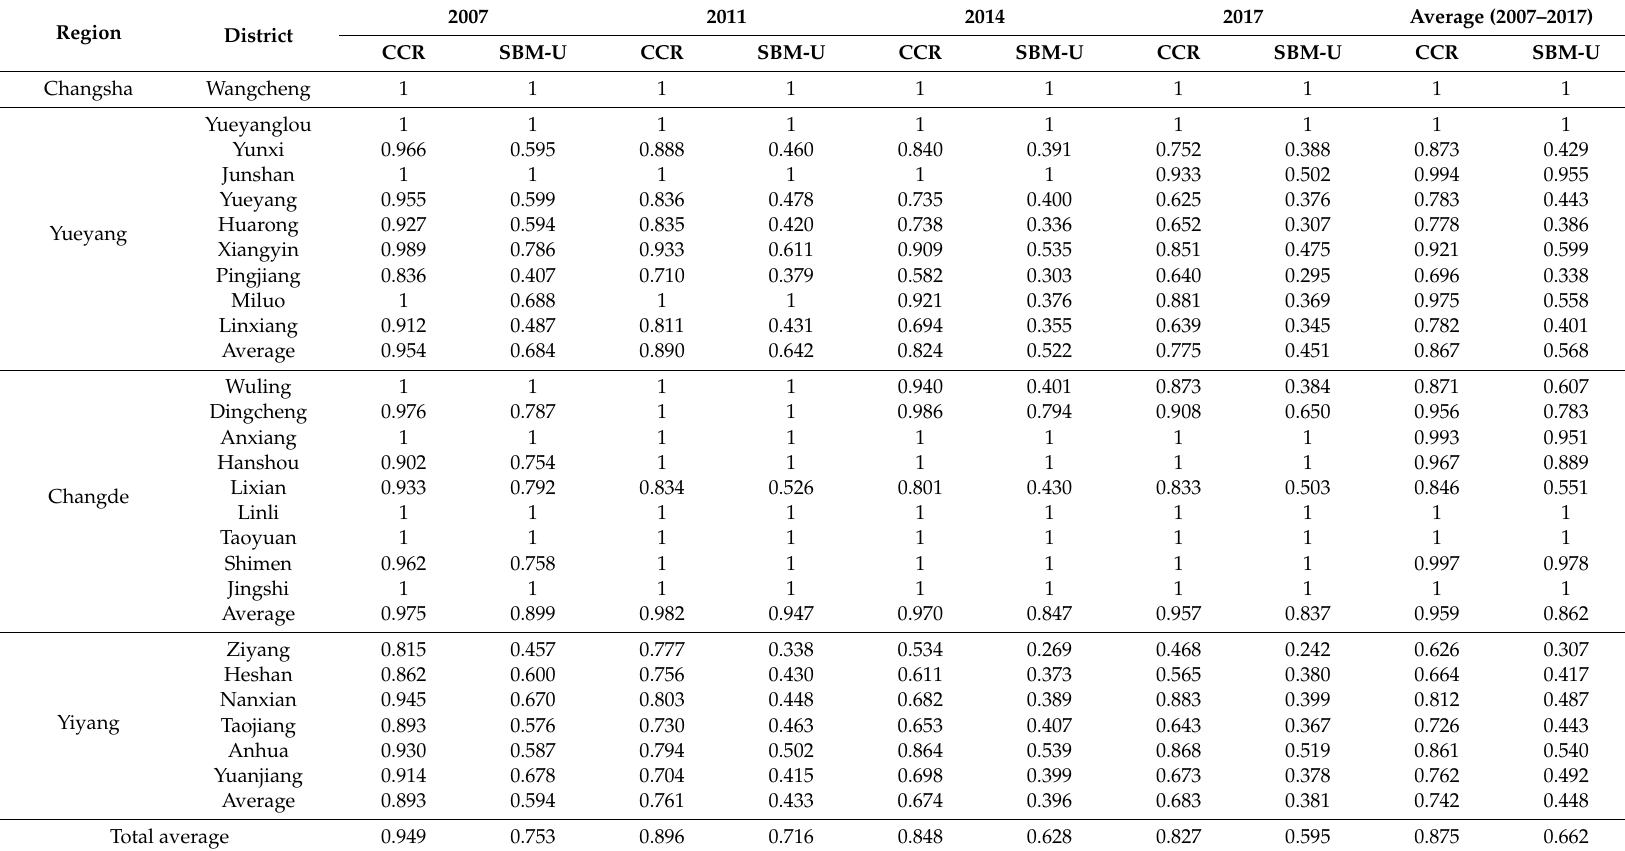
Table 4. Evaluation results of cultivated land use e ffi ciency in major